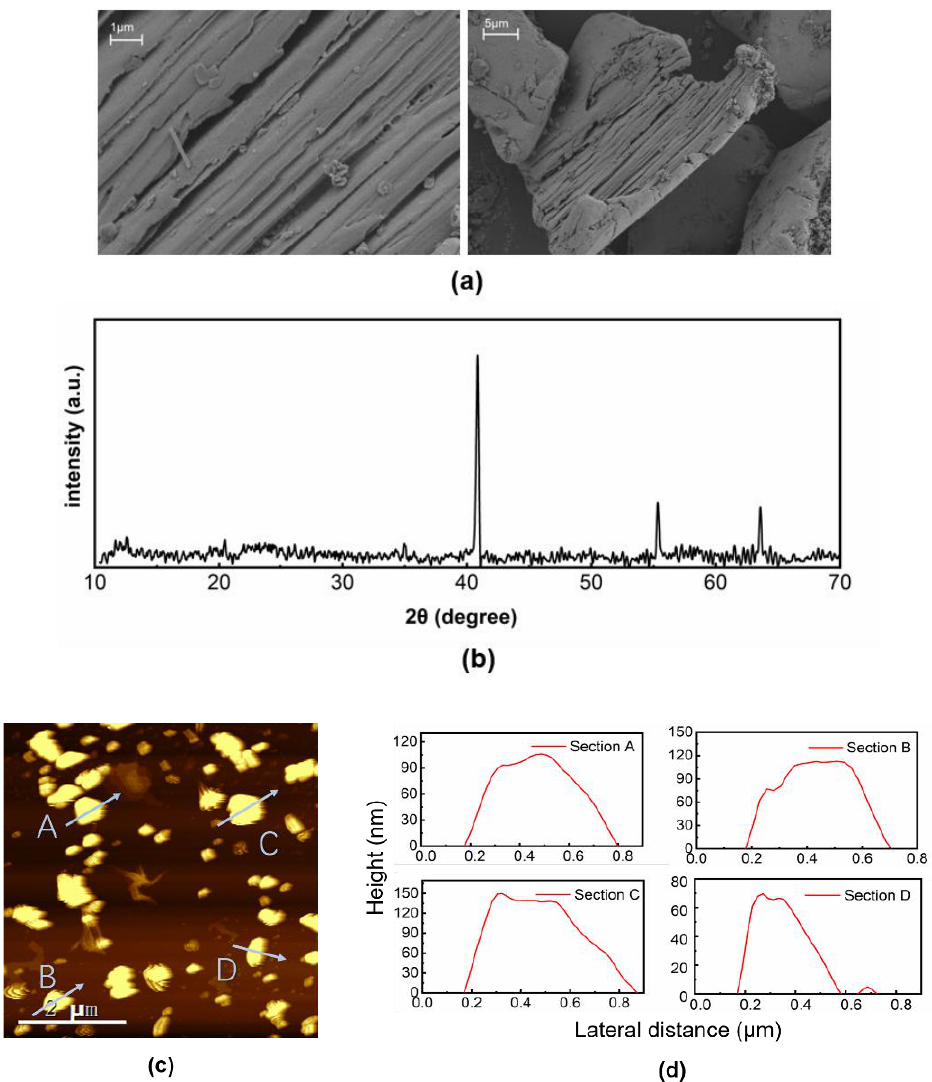
Figure 1. Systematic characterization of the prepared MXene VCrC: ( a ) SEM image, ( b ) XRD pattern, ( c ) AFM image, and ( d ) height profiles.